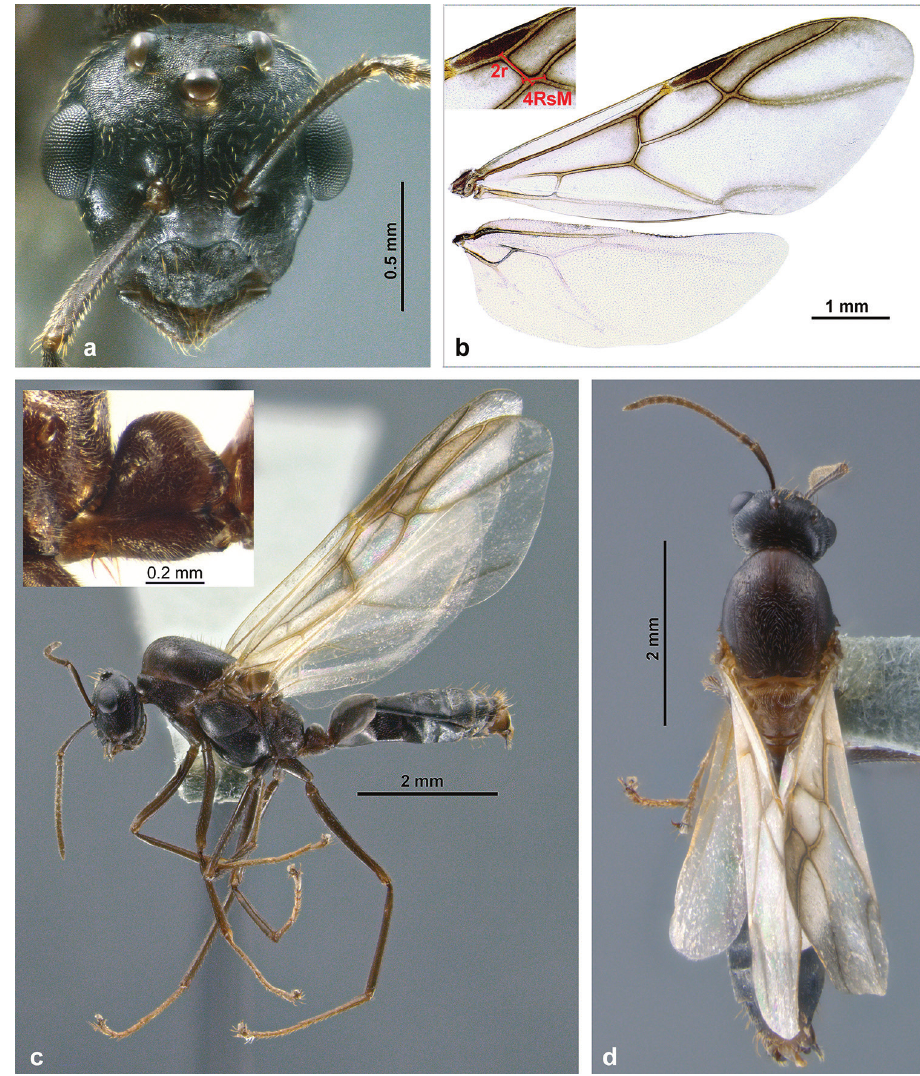
Figure 6. Habitus of C. explodens sp. n. allotype, male; a full-face view b wings (see insert for illustration of measurements 2r and 4RsM) c lateral (see insert for detailed view of petiole), and d dorsal view. some long setae. Basivolsella (Fig. 7e) dorsally with roundish structure, ventrally with evenly distributed, comparatively short setae. Digitus (Fig. 7e) large, evenly widened towards apex; apex rounded but with rectangular corner ventrally. Penis valvae (Fig. 7d) in dorsal aspect broad at base, but very narrow distally. Valviceps leaf-shaped in lateral view, apically rounded; surface smooth; ventral margin with very fine serration. Colour : Mainly dark chocolate-brown. Head somewhat darker; eyes pale grey to blackish; ocelli translucent, ranging from almost clear to reddish amber.